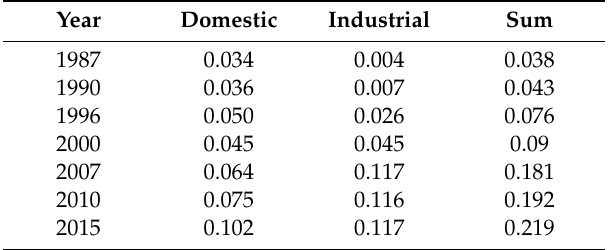
Table 4. Domestic and industrial water consumption in 1987–2015 (10 8 m 3